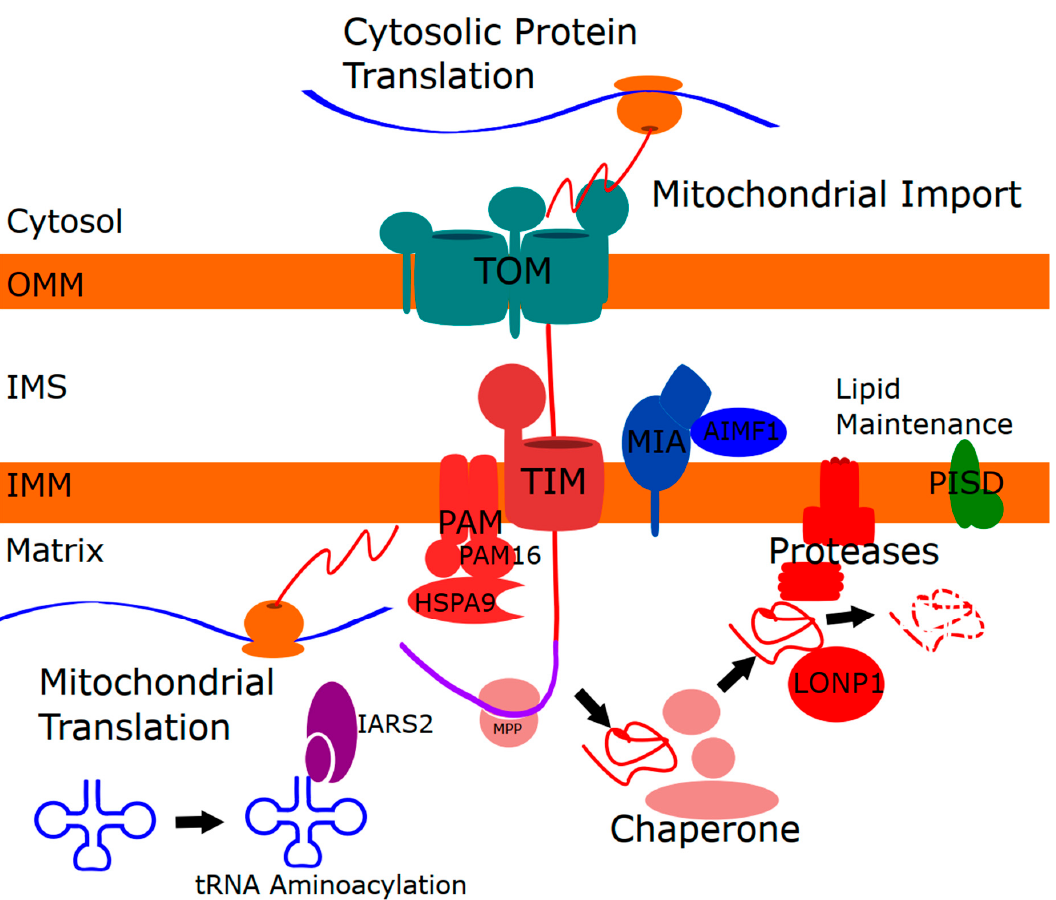
Figure 2. Model unifying the genes implicated in mitochondrial skeletal disorders to mitochondrial protein homeostasis. Proteases and chaperones mediate mitochondrial protein import and turnover of dysfunctional proteins. Impaired mitochondrial protein homeostasis inhibits mitochondrial protein import. IMM (inner mitochondrial membrane) lipid composition can impact proteases embedded in the IMM and is predicted to also impair mitochondrial protein import. Mitochondrial translation, which depends on tRNA aminoacylation, is essential for insertion of mtDNA-encoded proteins into the IMM, and is predicted to impact IMM proteases and / or mitochondrial protein import.